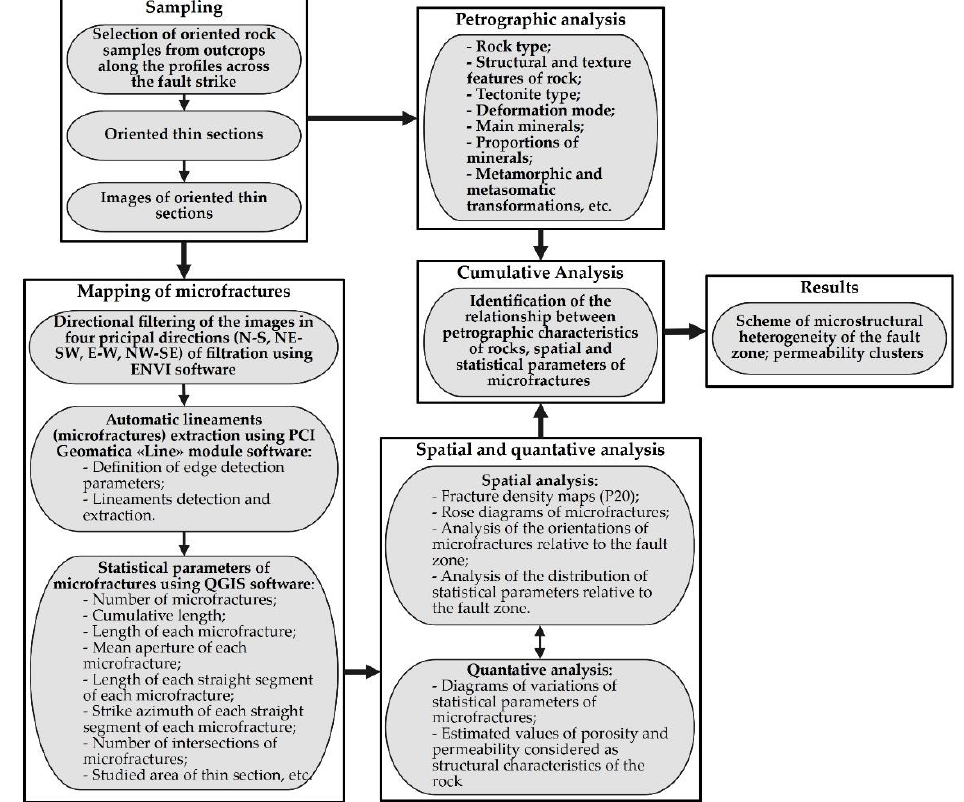
Figure 1. Flowchart of the research protocol.